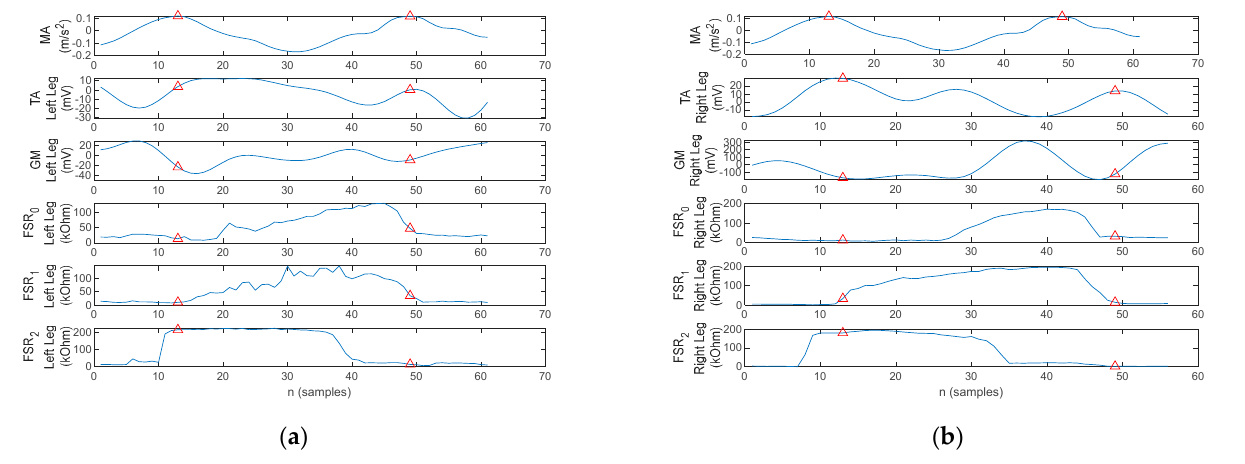
Figure 17. One-stance gait section plot of the arm balance MA, EMG of the TA and GM, and FSR signals for a healthy control, with the red triangles indicating the MA maxima: ( a ) left foot and ( b ) right foot.